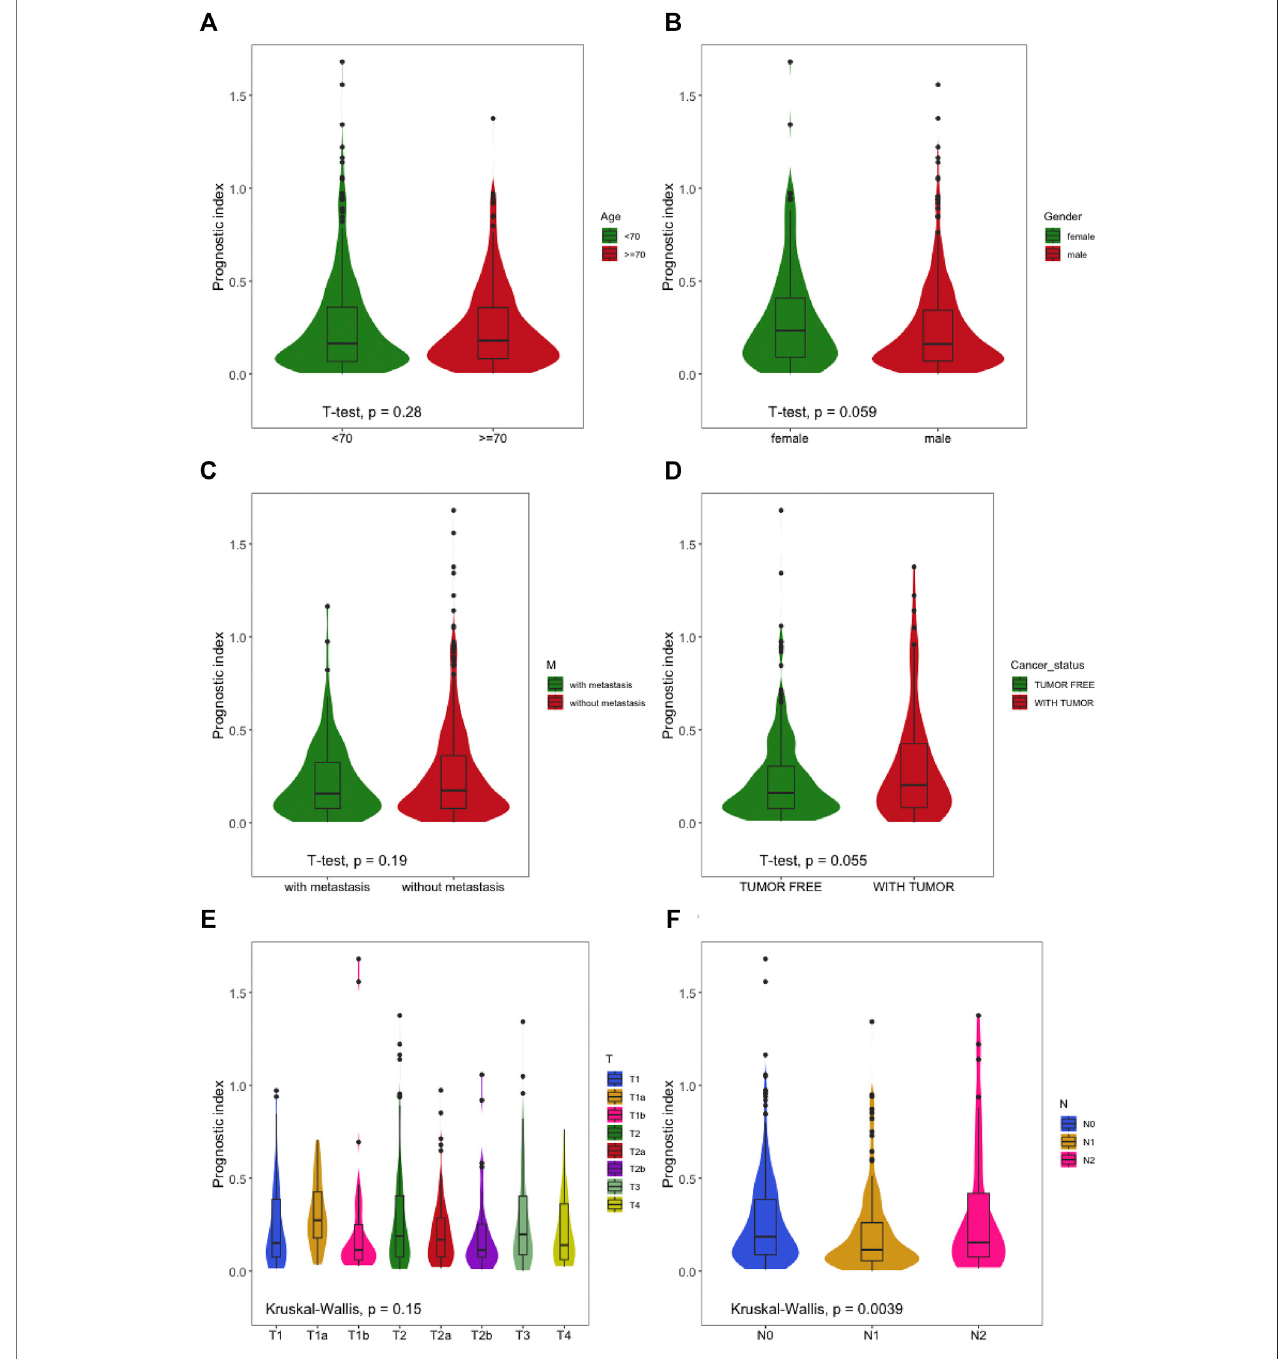
FIGURE 9 | The relationships between the immune-based prognostic index and clinical features. (A) Prognostic index and age; (B) prognostic index and sex; (C) prognostic index and distant metastasis; (D) prognostic index and cancer status; (E) prognostic index and T stage; (F) prognostic index and node metastasis.